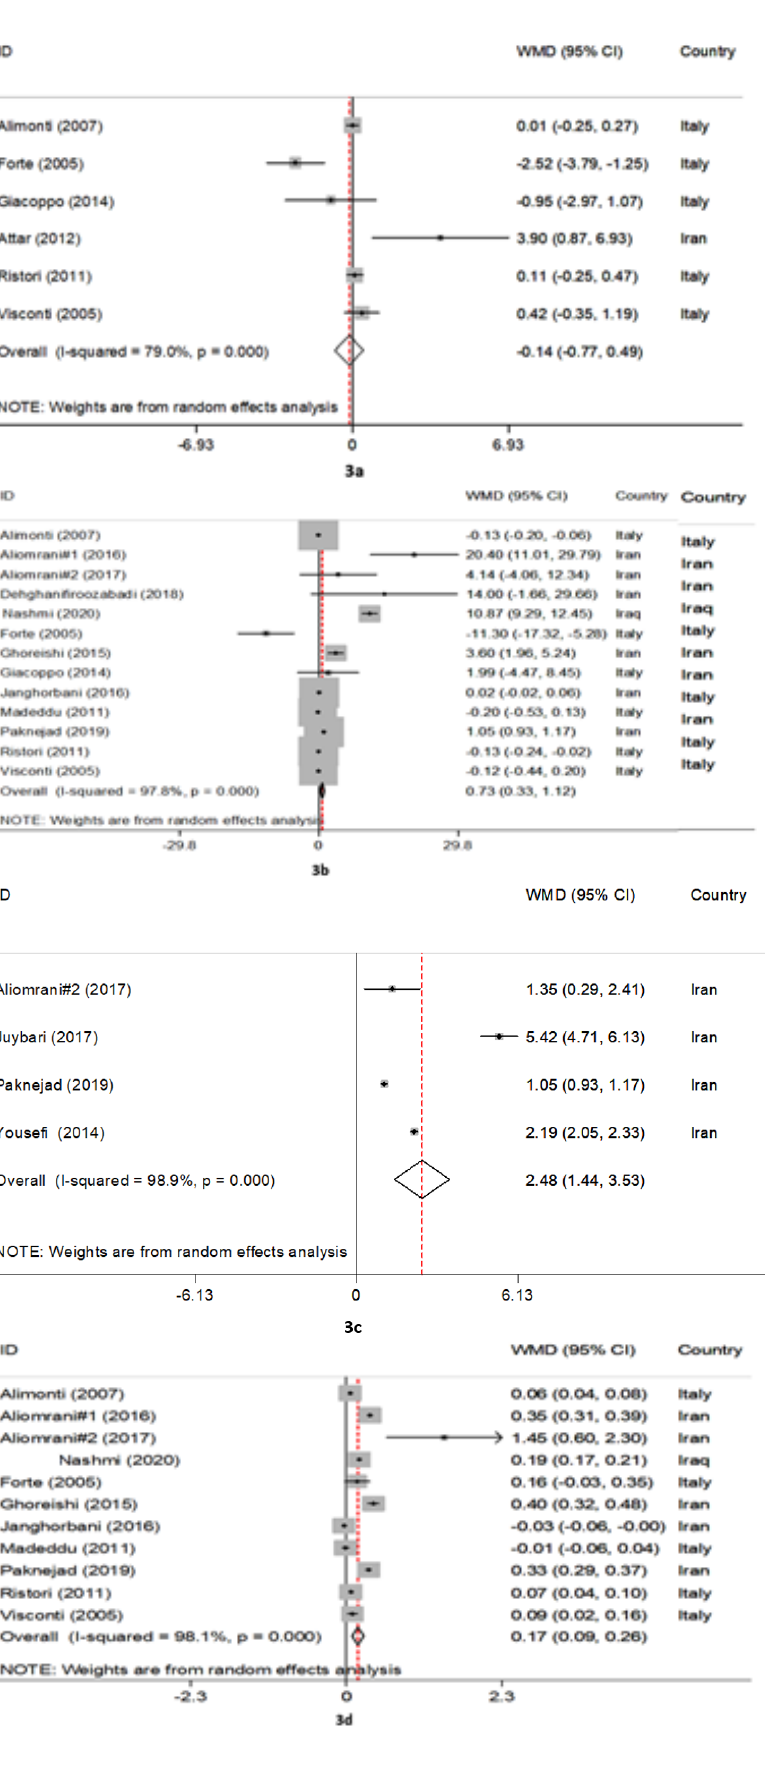
Figure 3: The forest plots of pooled estimates of the weighted mean differences on mercury ( a ), lead ( b ), arsenic ( c ), and cadmium ( d ) between MS patients and control